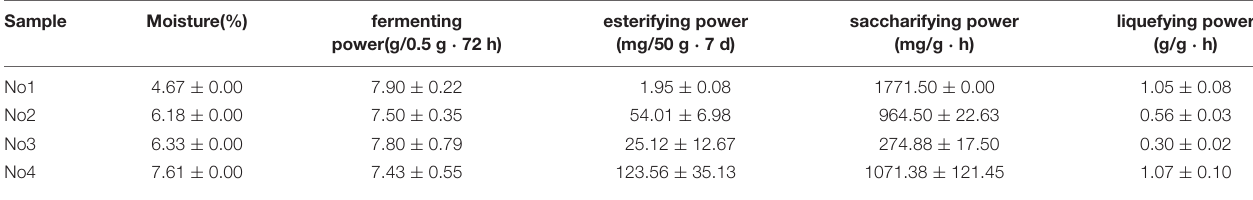
TABLE 1 | Differences in physicochemical properties of four Xiaoqu